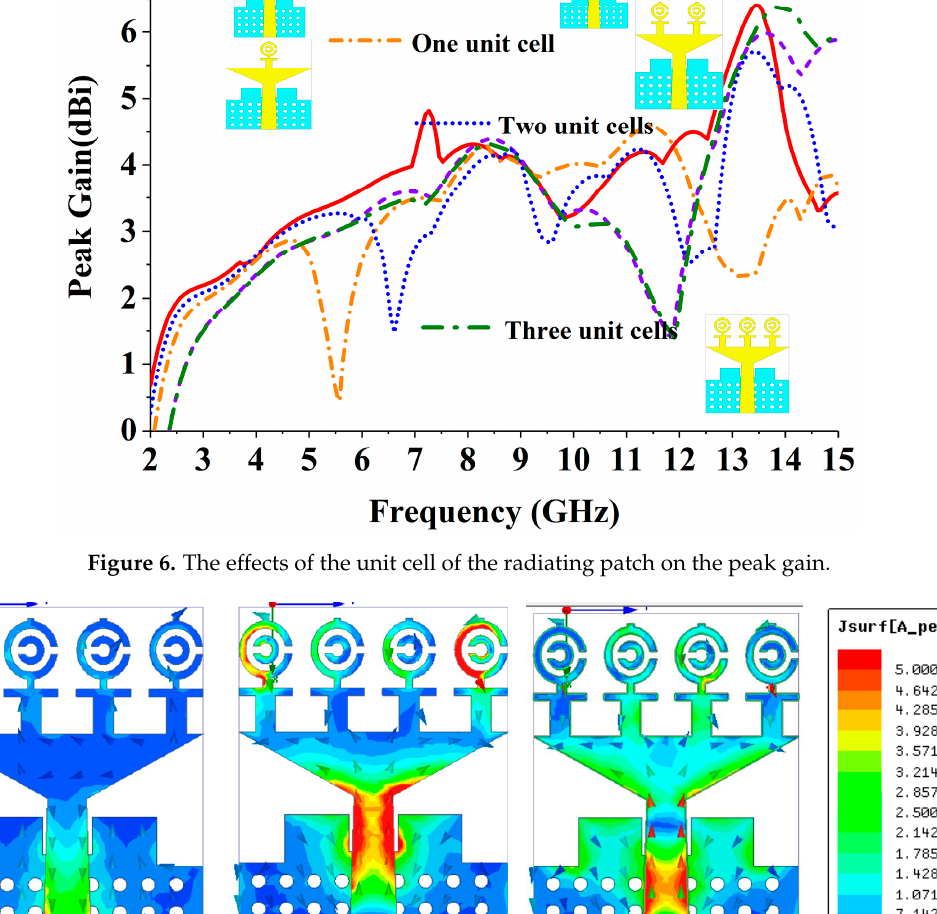
Figure 6. The effects of the unit cell of the radiating patch on the peak gain.